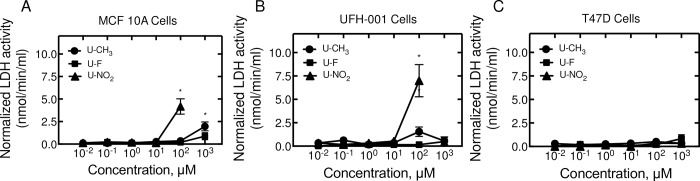
Effects of USBs on breast cancer cell viability.The cytotoxic effects of USBs were evaluated using the LDH release assay. MCF 10A (Panel A), UFH-001 (Panel B) and T47D (Panel C) cells were grown in 96-well plates and exposed to U-CH3, U-F or U-NO2 for 48 h, under normoxic conditions. LDH release was assayed after treatment, results were evaluated, and data analyzed using Prism. Data shown are representative of three independent experiments and as the mean ± SEM, *p < 0.05.